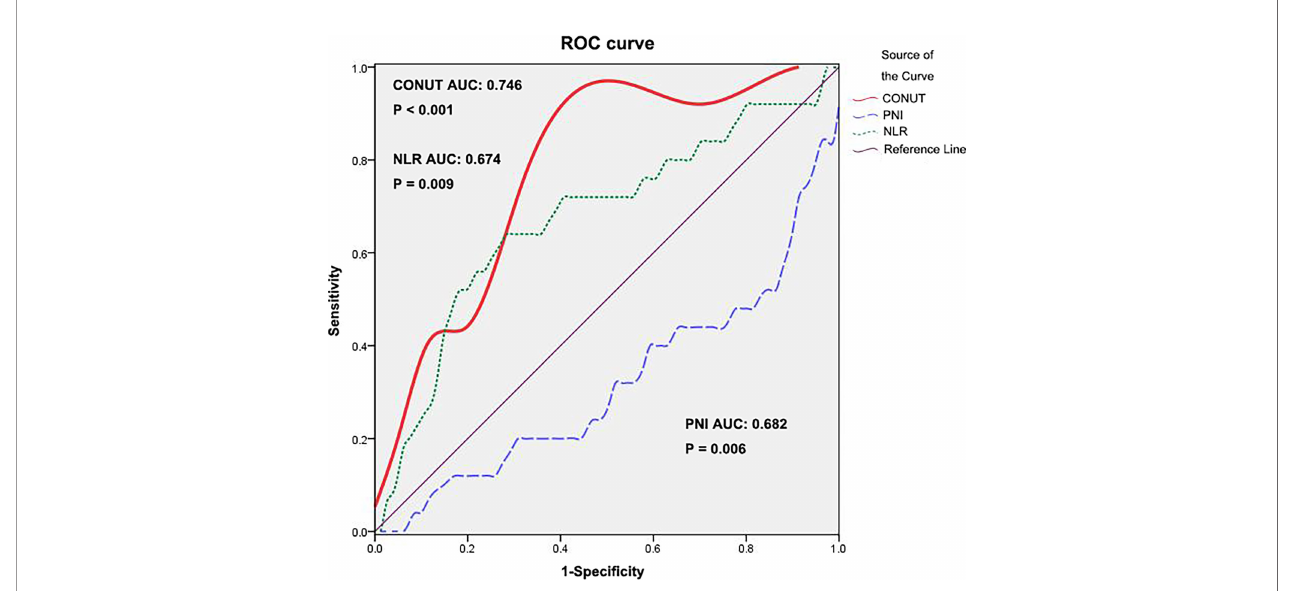
FIGURE 1 | ROC curve for CONUT, PNI and NLR. ROC, receiver operating characteristic; CONUT, controlling nutritional status; PNI, prognostic nutritional index; NLR, neutrophil – lymphocyte